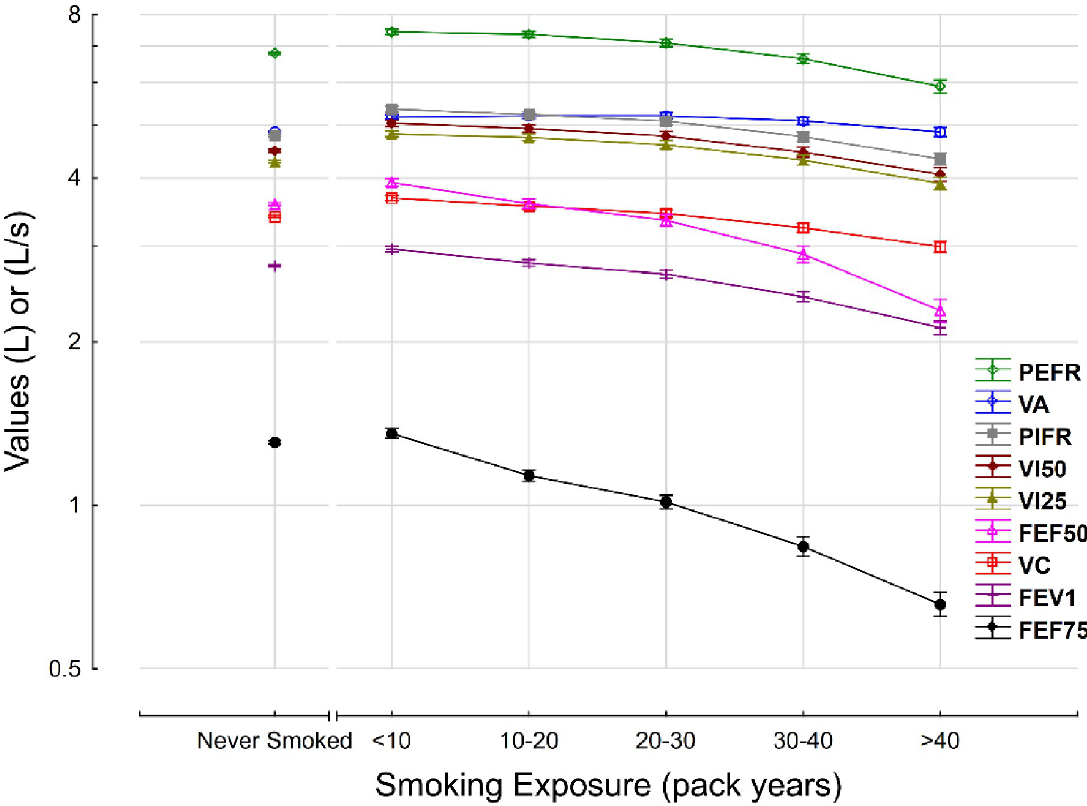
Fig 2. Effect of cigarette smoke exposure on lung volumes and flow rates. The y-axis is represented using logarithmic scale with base 2. FEF50; forced expiratory flow at 50%, FEF75; forced expiratory flow rate at 75%, FEV1; forced expiratory volume in 1 second, VA; alveolar volume, VC; vital capacity, VI25; inspiratory flow rate at 25%, VI50; inspiratory flow rate at 50%, PEFR; peak expiratory flow rate, PIFR; peak inspiratory flow rate.